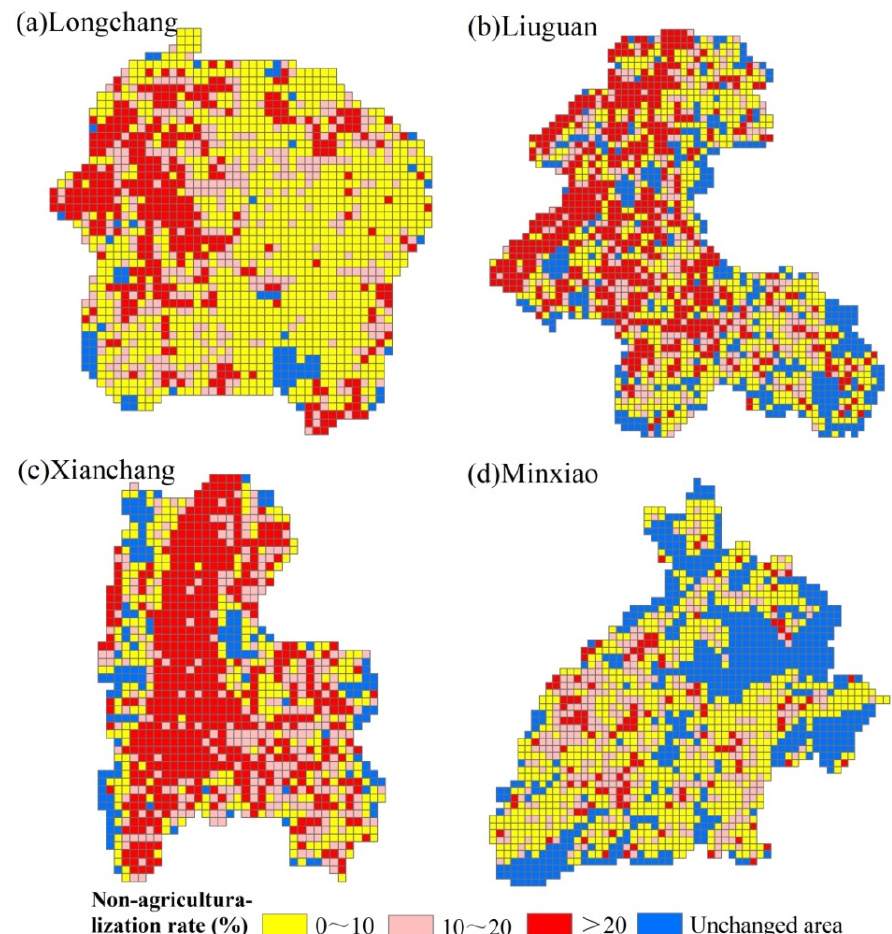
Figure 3. The spatial patterns of the non-agriculturalization of cultivated land from 2010 to 2020. ( a ) Longchang, ( b ) Liuguan, ( c ) Xianchang, ( d ) Minxiao.